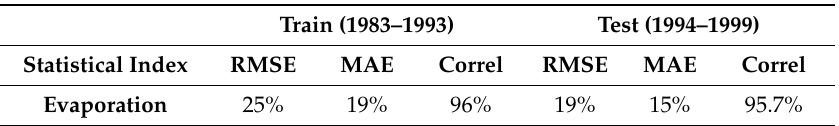
Table 4. Statistical indexes of error and correlation of the regression relationship between mean temperature and evaporation.